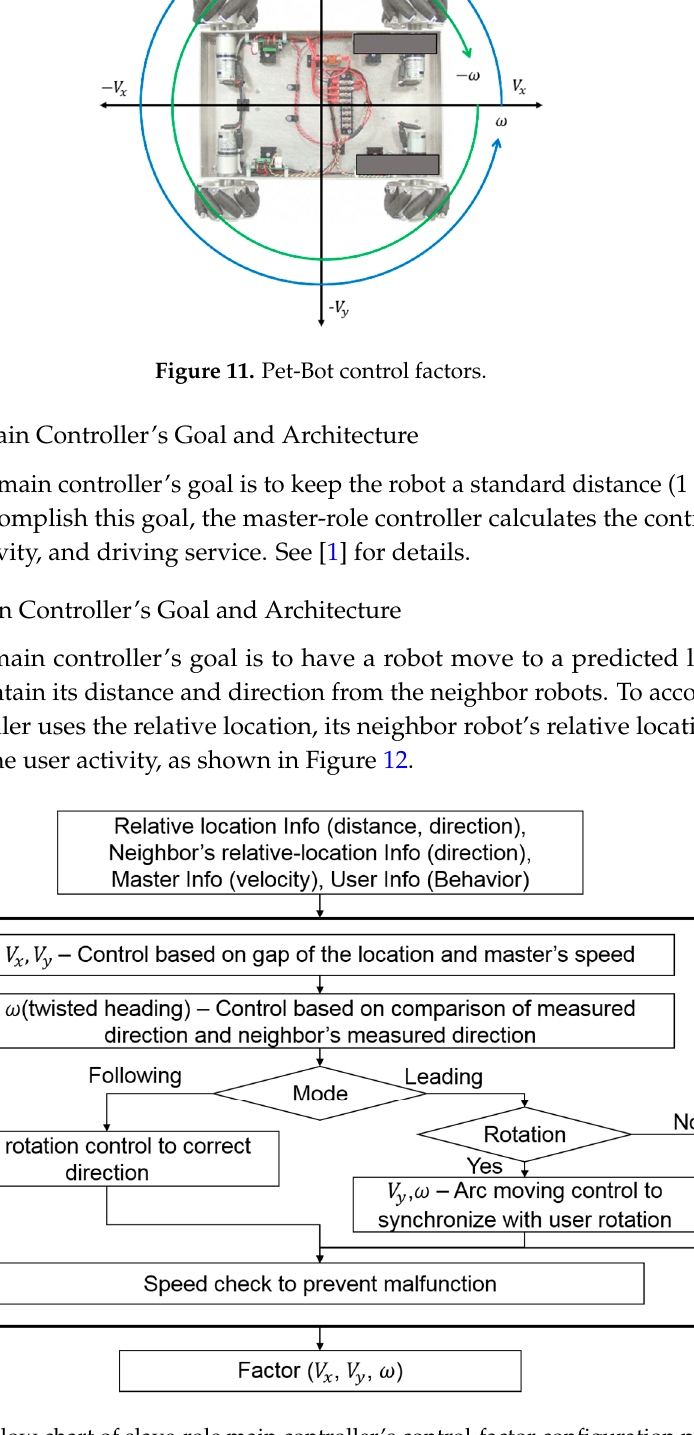
Figure 12. Flow chart of slave-role main controller’s control-factor configuration process.